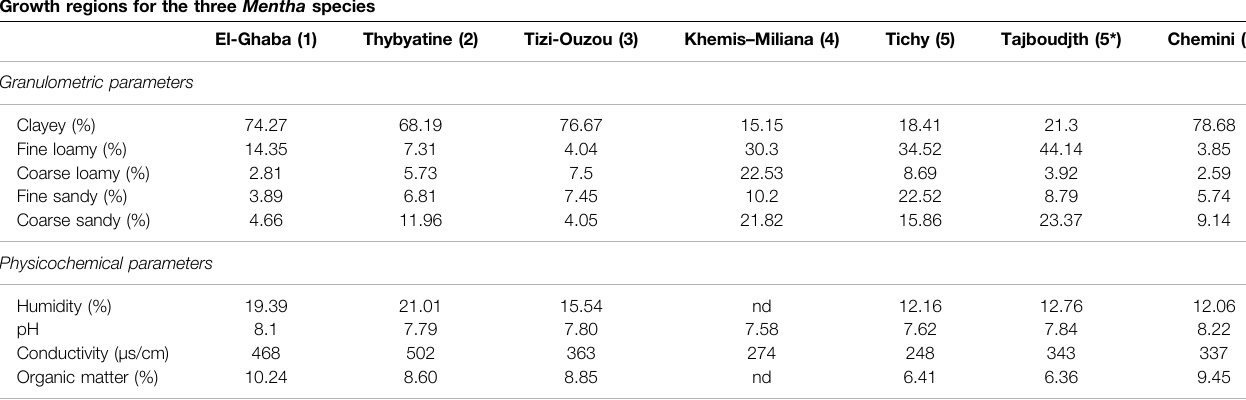
TABLE 2 | Granulometric and physicochemical analysis of the soil of the growth regions for the three Mentha species. Growth regions for the three Mentha